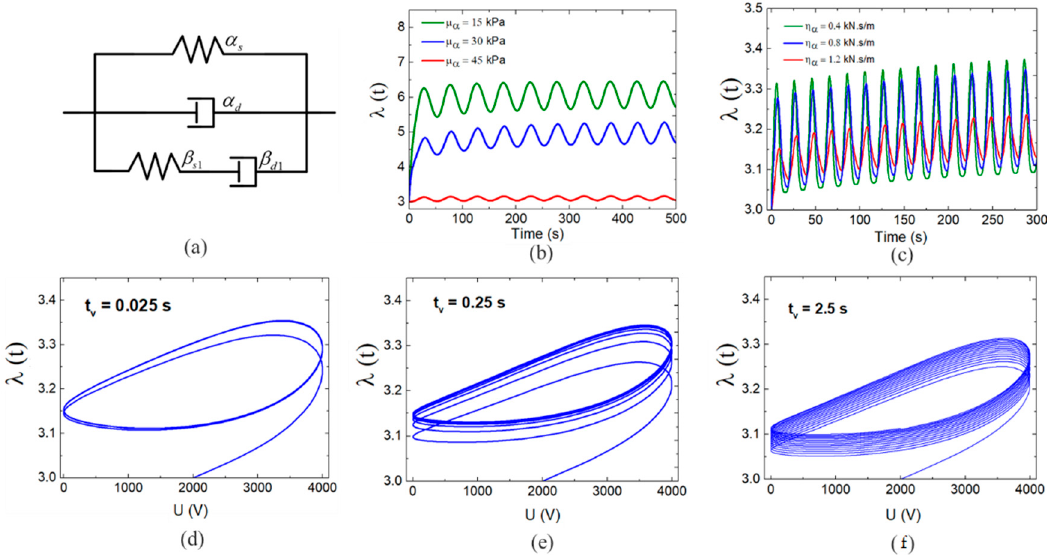
Figure 10. Influence of model parameters on alternating voltage responses: ( a ) one Maxwell unit rheological model, ( b ) the response of the model under different shear modulus of the spring α s , ( c ) the response of the model under different viscous damping of the dashpot α d , ( d – f ) the hysteresis loop of the model response under different relaxation